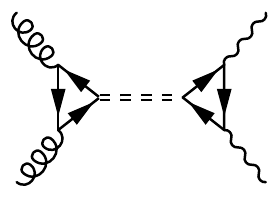
Figure 14. gg ! H ! (cid:13)(cid:13) .